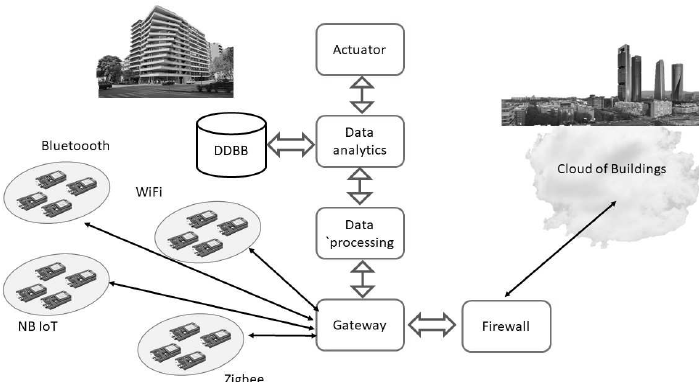
Figure 1. Overview of the smart building connectivity both at building and cloud